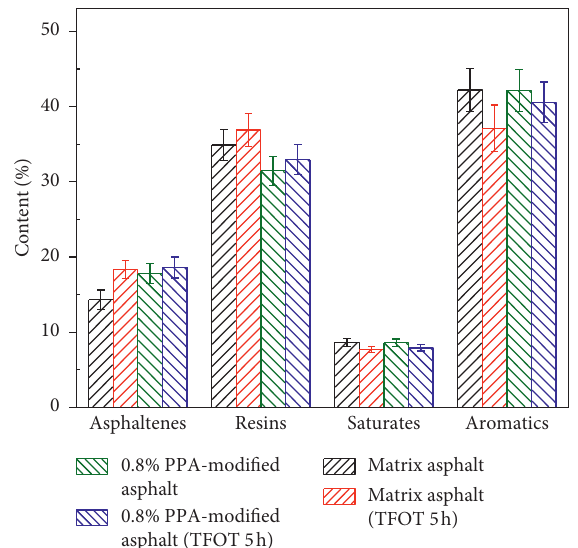
Figure 7: Variation of four components before and after aging of matrix asphalt and PPA-modified asphalt.